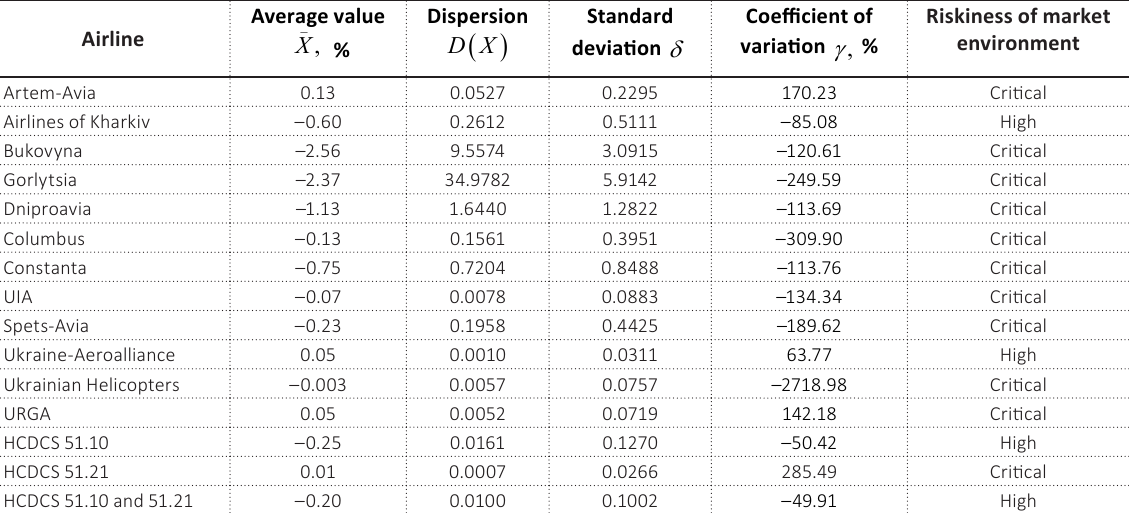
Table 2. Risk assessment statistics for Ukrainian airlines in